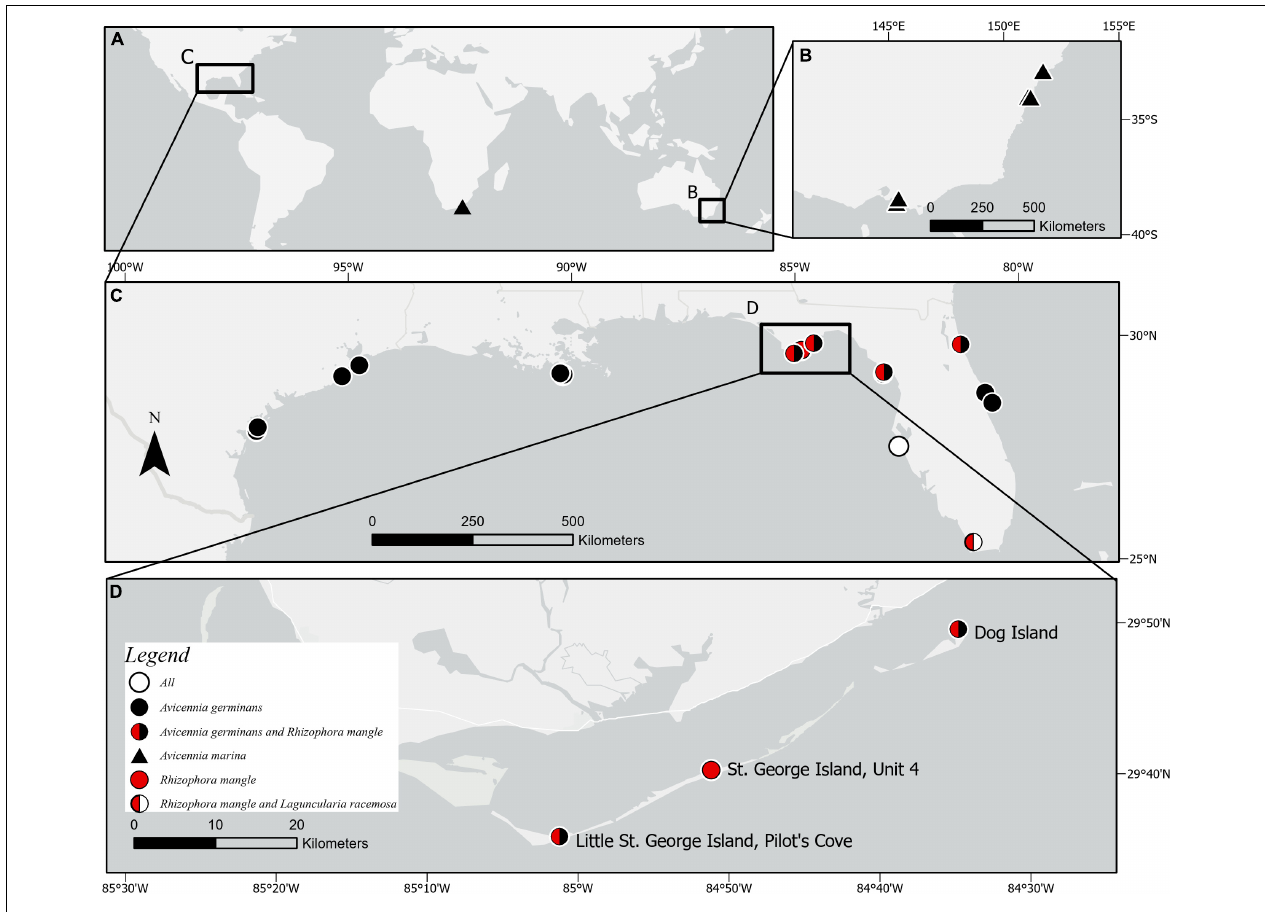
FIGURE 1 | (A) Global extent of sites experiencing mangrove encroachment into tidal marsh with measurements of soil organic carbon (References in Table 4 ) with insets of (B) Southeast Australia, (C) North America, and (D) Study area of Apalachicola Bay region, including Dog Island, St. George Island, and Little St. George Island. The single study documenting mangrove encroachment into tidal marsh with a measurement of soil organic C in S. Africa is shown on the global